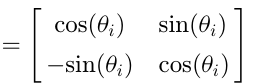
Fig. 2. Examples of convex polyhedrons: (a) a regular tetrahedron with edge length length 1; (b) convex polyhedron related to Model B; (c) convex polyhedron related to Model C; 1 – the edge is fl ush with the Top side; 2 – the edge is fl ush with the